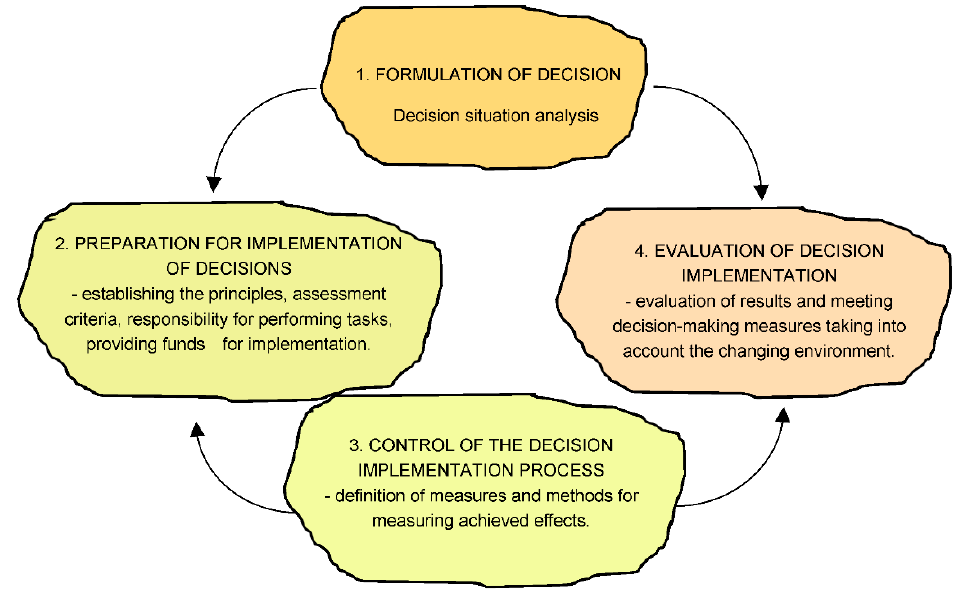
Figure 4. The process of making and implementing a decision.